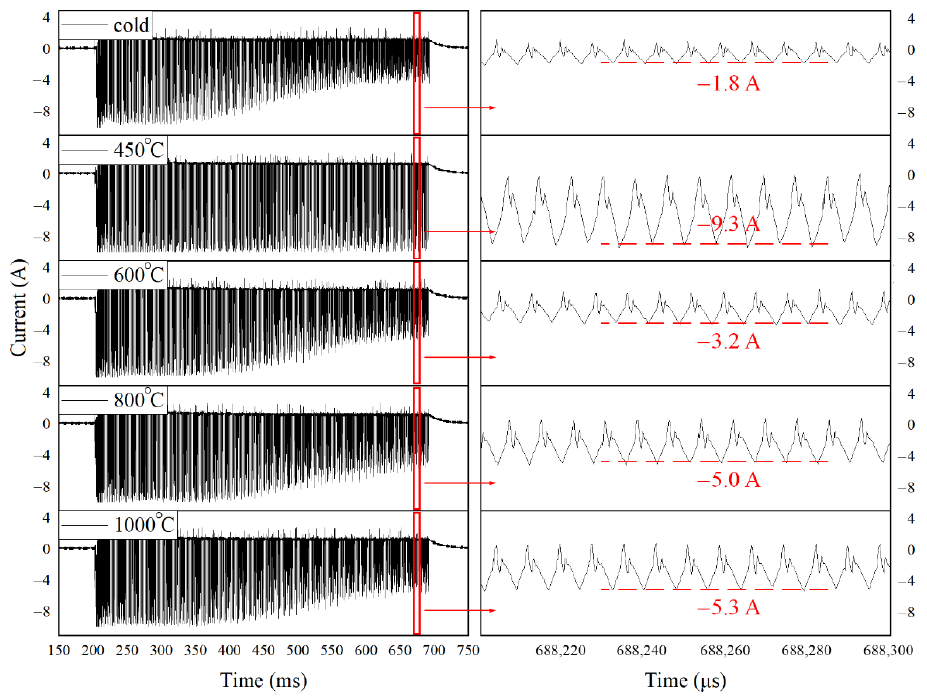
Figure 4. Current waveforms measured during the sputtering of 1.5 mm nickel target at various temperatures .